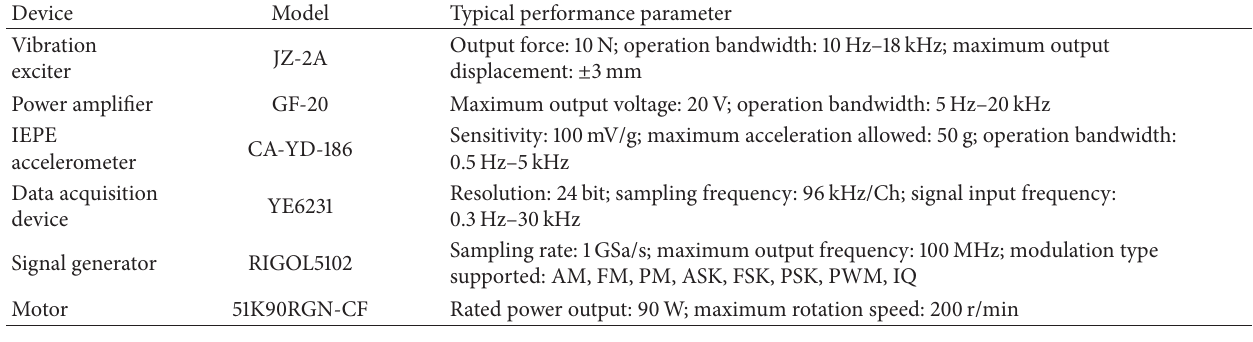
Table 3: Typical performance parameter of experimental devices.